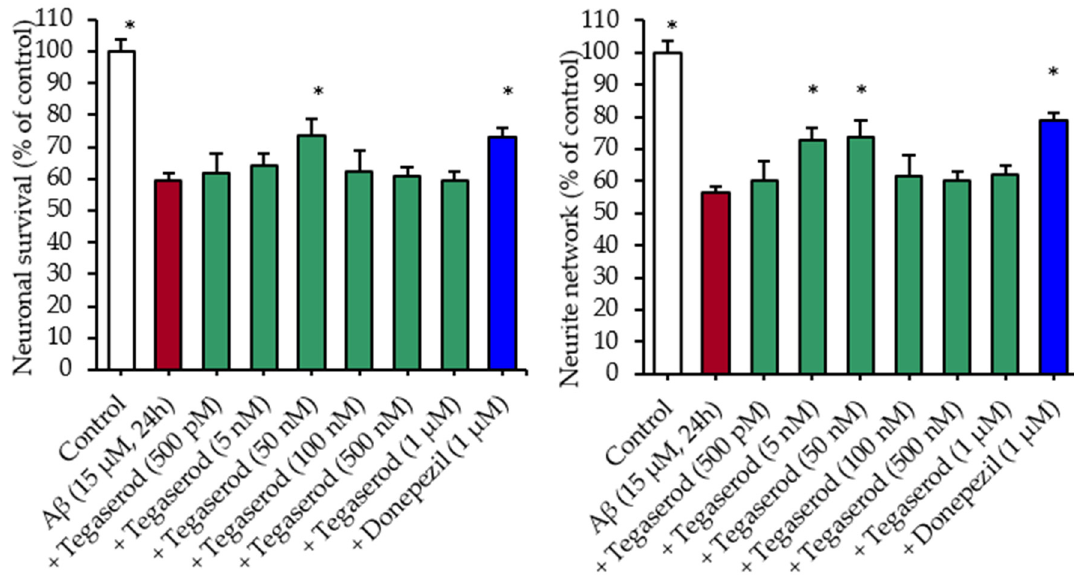
Figure 2. Neuronal survival and neurite network in a primary culture of cortical neurons injured with A β . * p < 0.05 versus A β 1–42